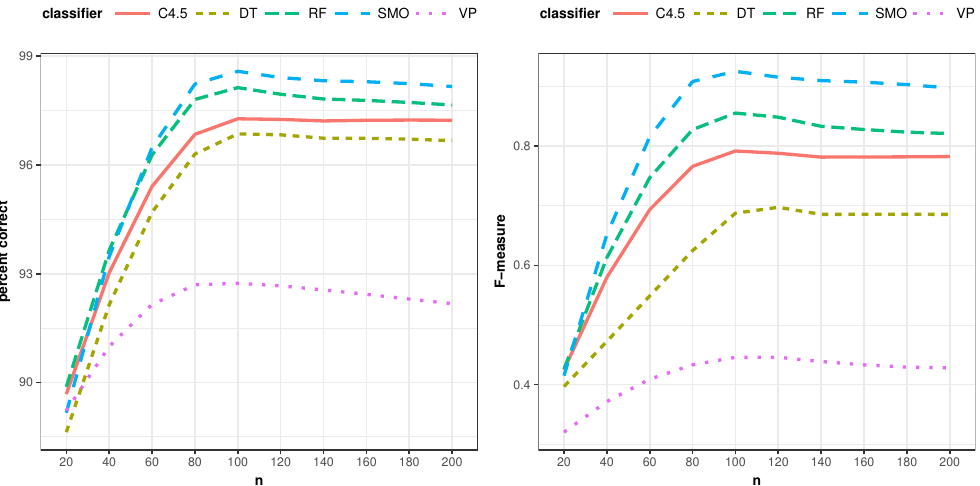
Figure 5. Evolution of the average percentage of correctly-classified instances and F-measure.